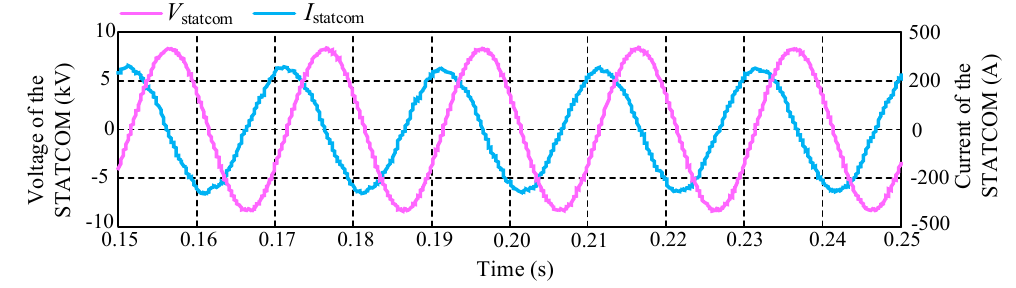
Figure 18. A ‐ phase voltage and current of the STATCOM. Figure 18. A-phase voltage and current of the Table 3. Active power and reactive power at the public network side and power loss of new grid ‐ connected transformer.